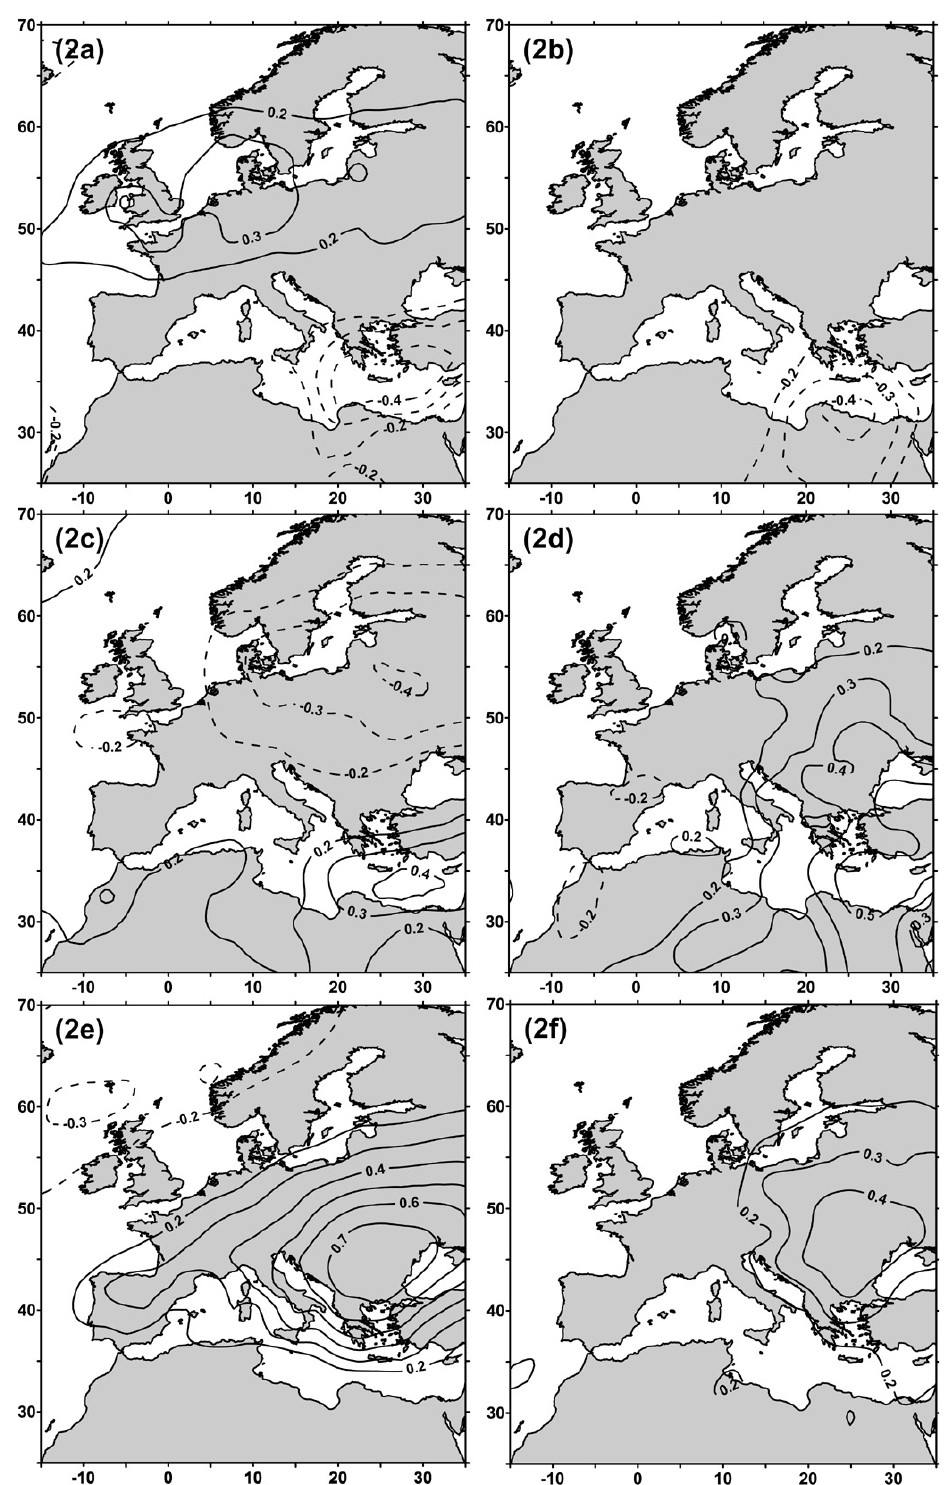
Figure 2. Correlation maps between TPW and (a) shortwave radiation during winter, (b) shortwave radiation during summer, (c) longwave radiation during winter, (d) longwave radiation during summer, (e) latent heat during winter and (f) latent heat during summer. Dashed lines indicate negative